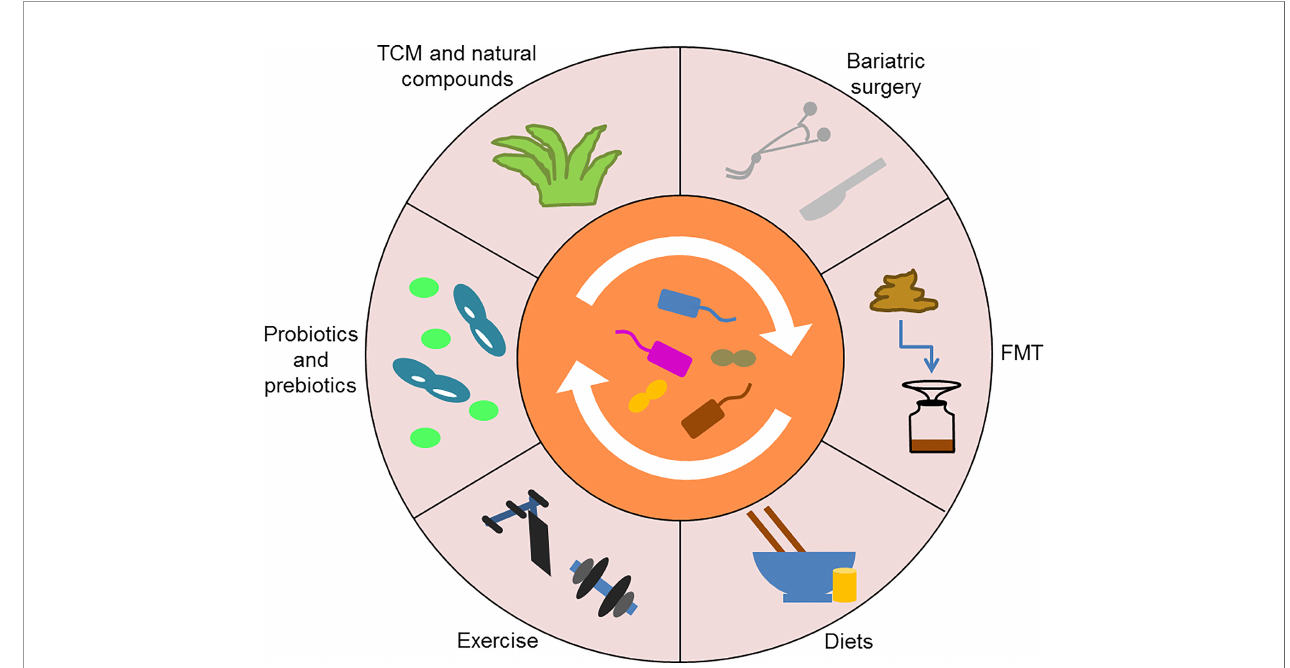
FIGURE 5 | Various antidiabetic interventions targeting the gut microbiota. Probiotics and prebiotics, TCM and natural compounds, as well as certain non-drug therapies, such as bariatric surgery, FMT, diets, and exercise, can reshape the gut microbiota to treat T2DM. TCM, Traditional Chinese medicine; FMT, Fecal microbiota